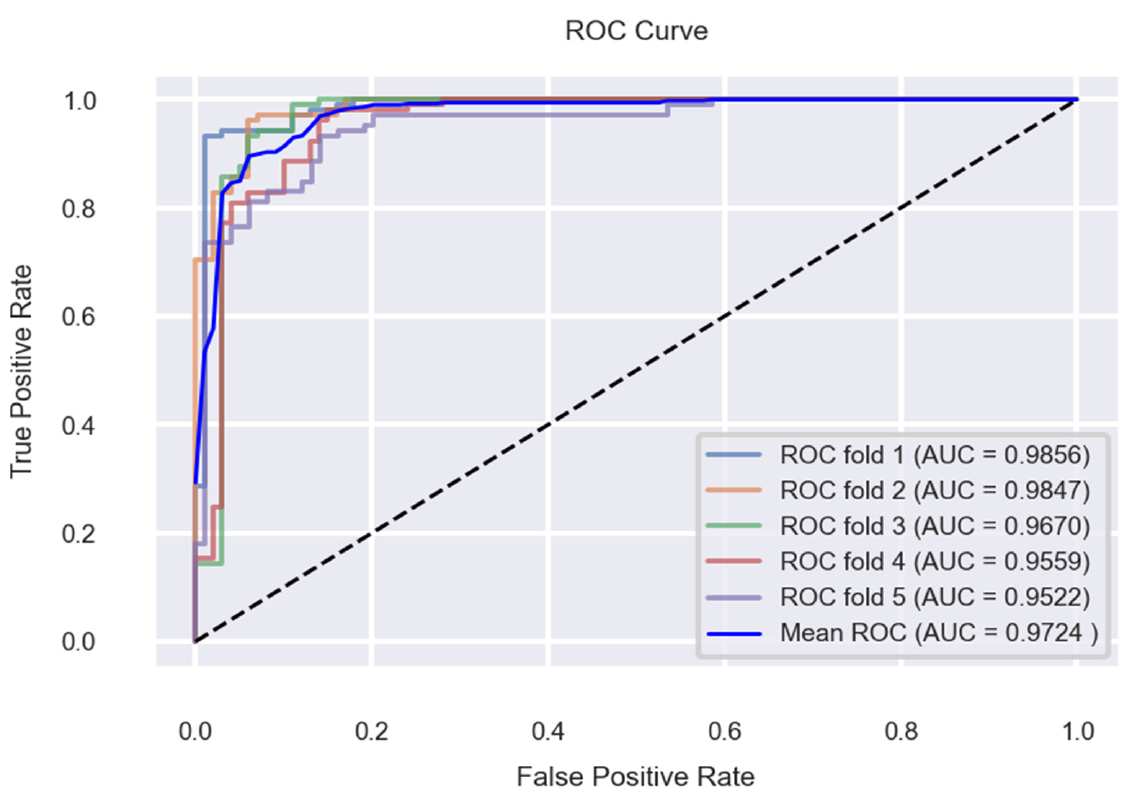
Figure 28. Stratified (K = 5)-Fold Cross-validation Results for Naive Bayes (ROC-AUC).